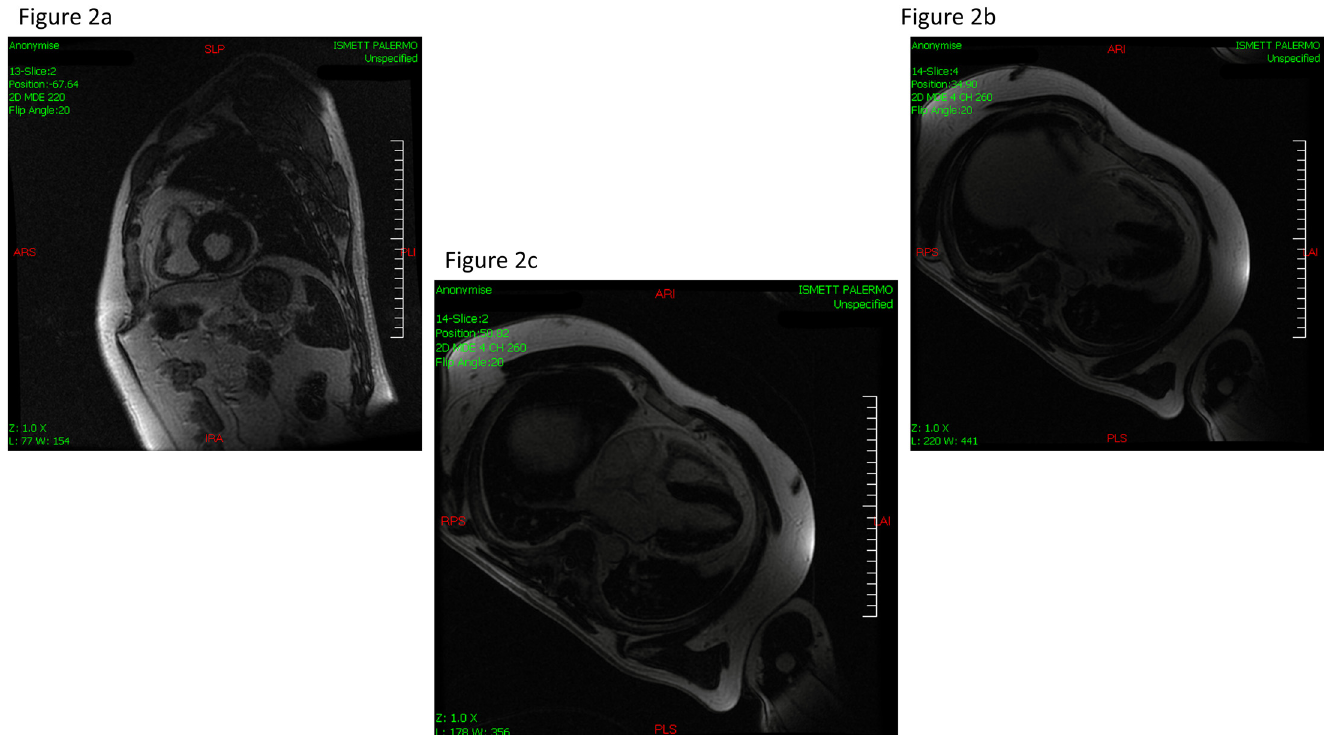
Fig 2. Late Gadolinium Enhanced Cardiac Magnetic Resonance in the only kidney donor positive for myocardial fibrosis. Short axis view at the middle level, delayed enhancement suggestive of patchy fibrosis at the inferior wall. (a) Four chambers view, delayed enhancement suggestive of patchy fibrosis at the basal lateral segment. (b)